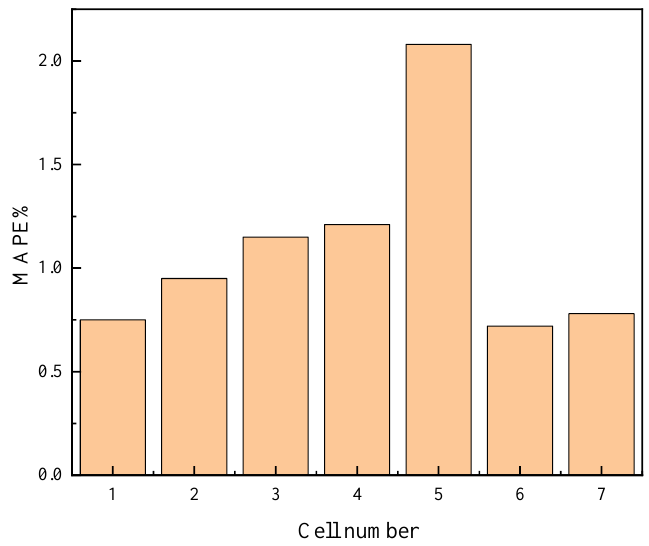
Figure 9. Results of the estimation.